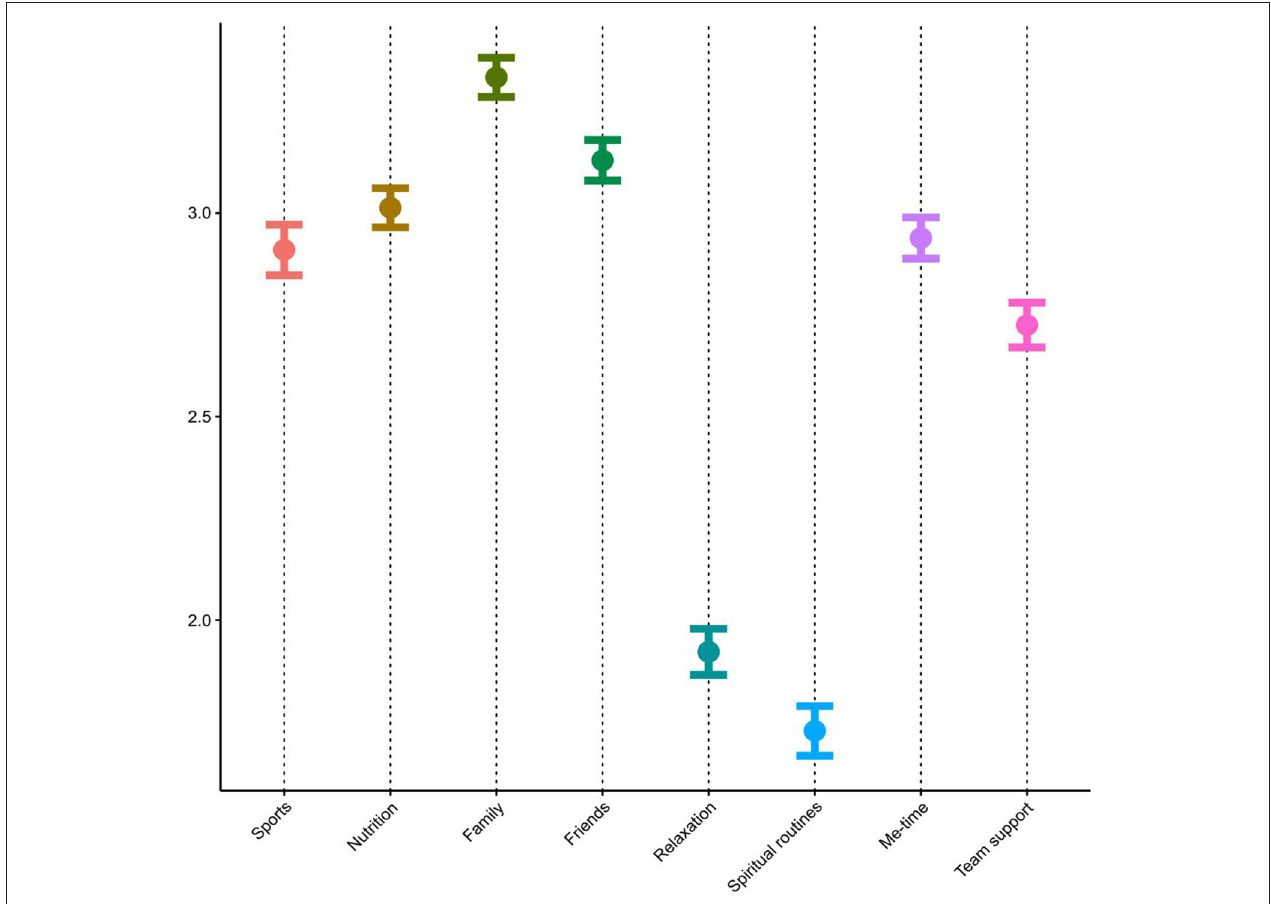
FIGURE 1 | Use of self-care strategies (self-report on a four-point Likert scale from 1, “totally disagree,” to 4, “totally agree”).